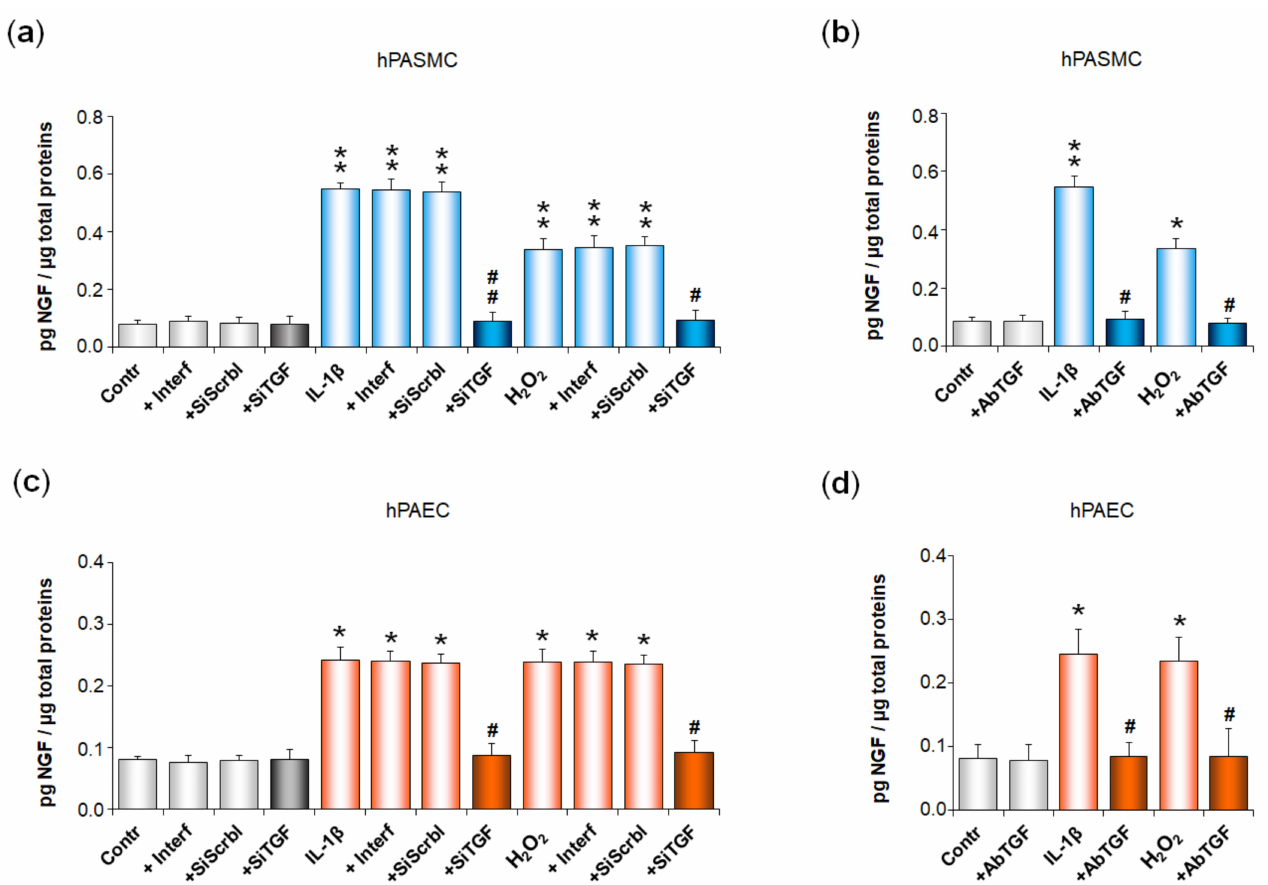
Figure 4. Role of TGF- β 1 in IL-1 β - or H 2 O 2 -induced increase in NGF secretion by human pulmonary arterial cells. NGF secretion by human pulmonary arterial smooth muscle cells (hPASMC, ( a , b )) or human pulmonary arterial endothelial cells (hPAEC, ( c , d )) was assessed in the absence or presence of interleukin-1 β (IL-1 β , 10 ng/mL, 24 h) or hydrogen peroxide (H 2 O 2 , 10 µ M, 24 h). Involvement of the transforming growth factor- β 1 (TGF- β 1) was investigated in ( a ) hPASMC or ( c ) hPAEC pre-treated for 48 h with an anti-TGF- β 1 siRNA (SiTGF, 1 nM). Effect of this anti-TGF- β 1 siRNA on NGF basal secretion was evaluated. Furthermore, the effects of the transfecting agent INTERFERin ® (Interf) alone and of a non-relevant scramble siRNA (SiScrbl, 1 nM) on NGF basal and induced secretions were evaluated. TGF- β 1 involvement was also investigated through pre-treatment (30 min) of ( b ) hPASMC or ( d ) hPAEC with anti-TGF- β 1 blocking antibodies (AbTGF, 1 µ g/mL). Effect of these antibodies on NGF basal secretion was evaluated. NGF secretion was determined by ELISA (results expressed as pg NGF/ µ g total proteins). The data represent the means ± SEM of n = 5 independent experiments performed in triplicate on cells from three to five control donors. * p < 0.05 and ** p < 0.01 versus untreated control cells (Contr). # p < 0.05 and ## p < 0.01 versus cells treated with either IL-1 β or H 2 O 2